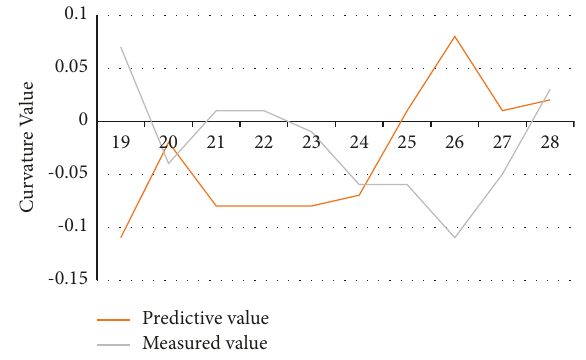
Figure 6: Curvature value comparison curve.